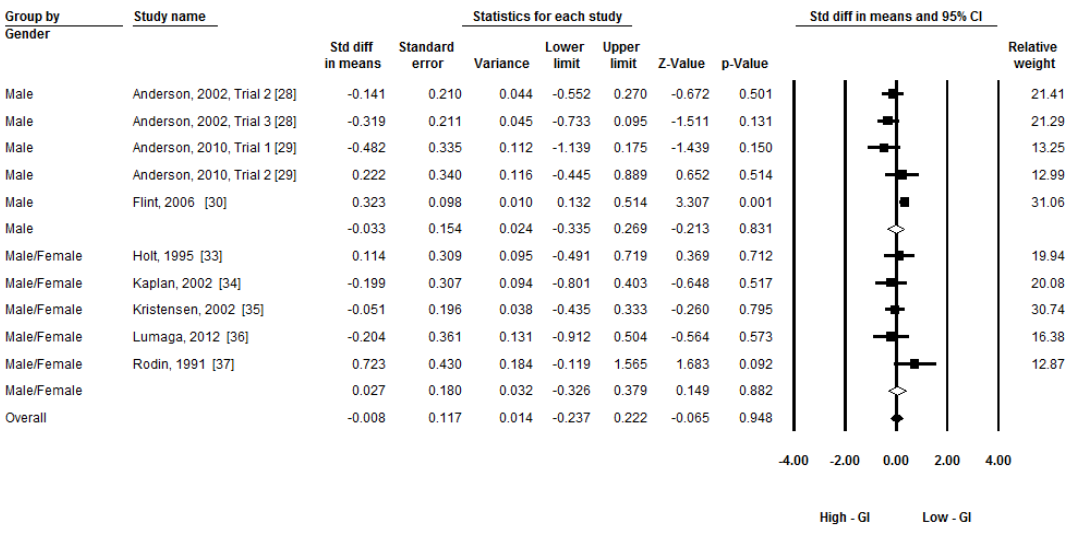
Figure 6. Subgroup meta-analysis: The effect of low-GI and high-GI breakfast on subsequent energy intake between gender groups. (GI: Glycemic Index).